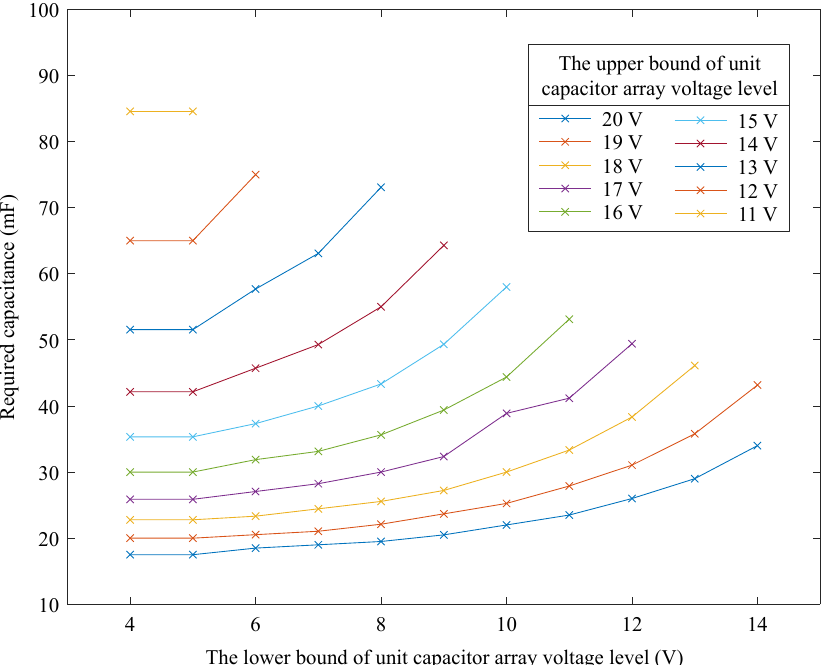
Figure 6. The relation among the lower and the upper bound of the unit capacitor array voltage level and required capacitance to supply 2.3 J of deficient energy considering DC–DC converter